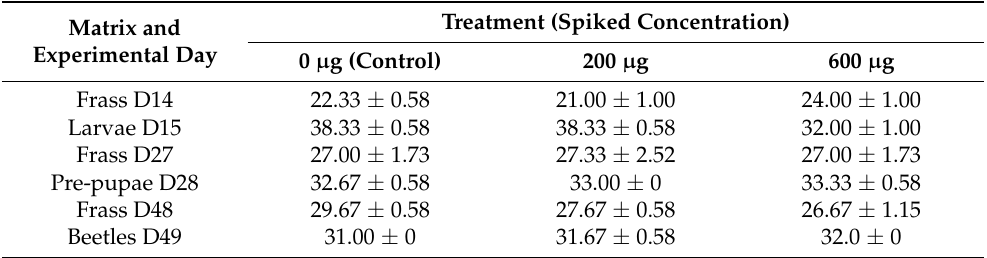
Table 1. Weight of frass and insects on experimental day on which the matrix was collected, for each of the three treatments. Mean and standard deviation. Matrix and